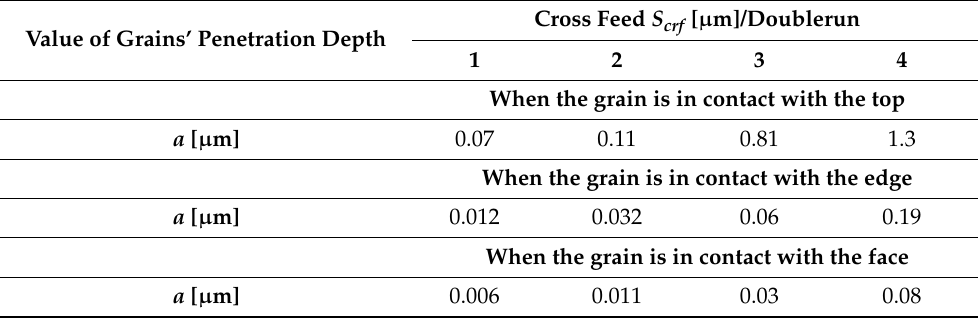
Table 4. Influence of loading conditions of the system with cross feed on the value of the penetration of grains into the